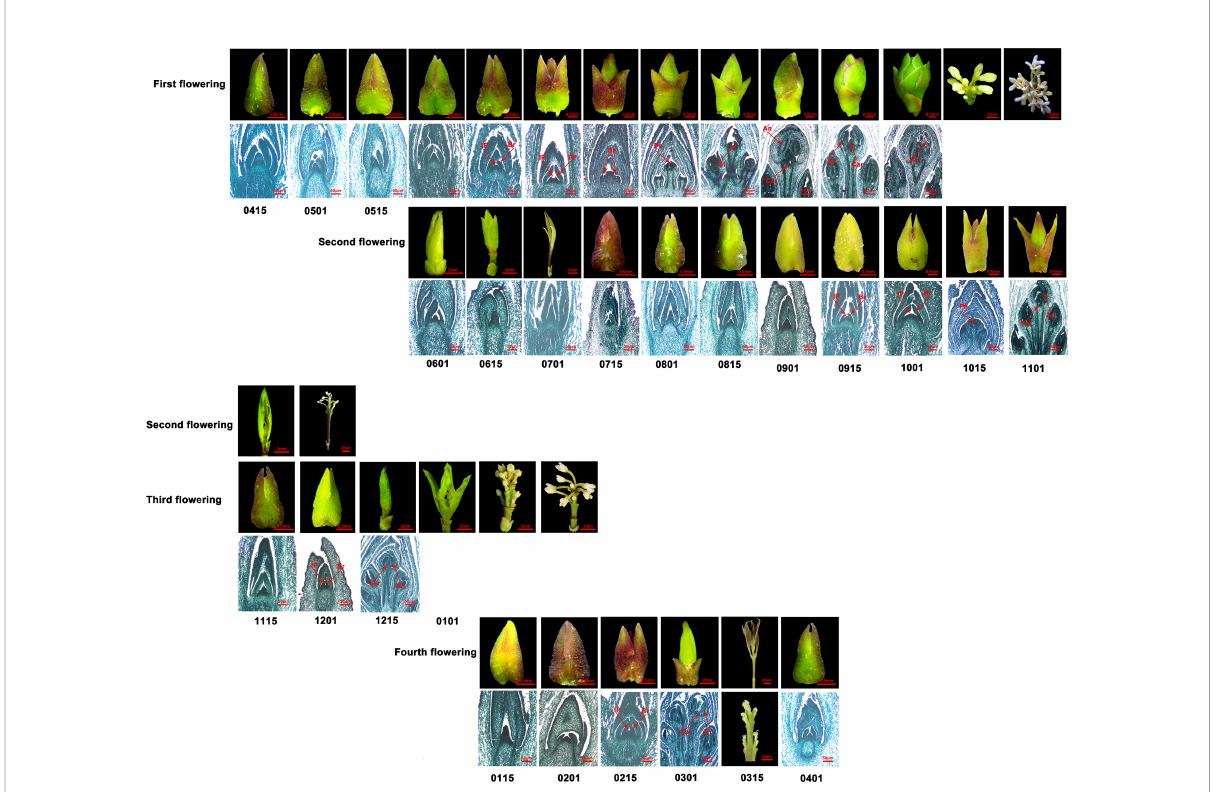
FIGURE 2 The fl owering phenology shifts in O. fragrans ‘ Sijigui ’ for 1 year. First to fourth fl owerings respectively represent different fl owering processes in 1 year. The numbers below the picture represent dates. For example, 0115 is January 15. Br, bract; Ip, in fl orescence; FP: fl oret primordium; Se, sepa primordium; Pe, petal primordium; St, stamen primordium; An, anther; Car,